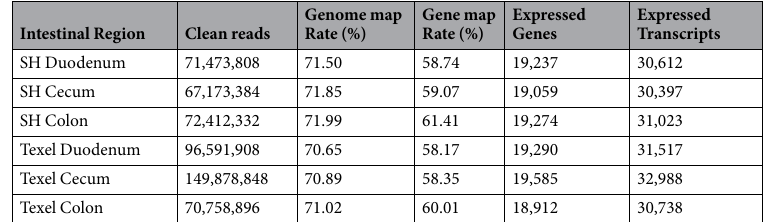
Table 1. A summary of the sequencing read alignments to the sheep reference genome and genes.